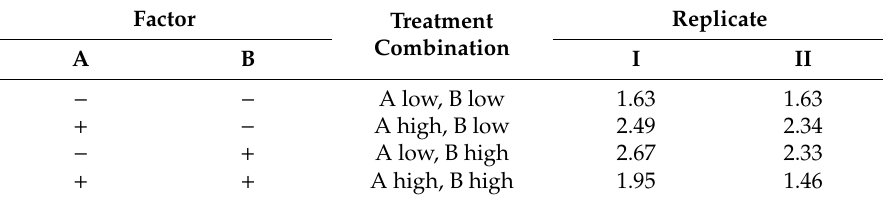
Table 2. Factorial design with standard deviation of compartment temperatures ( δ ) as response variable.